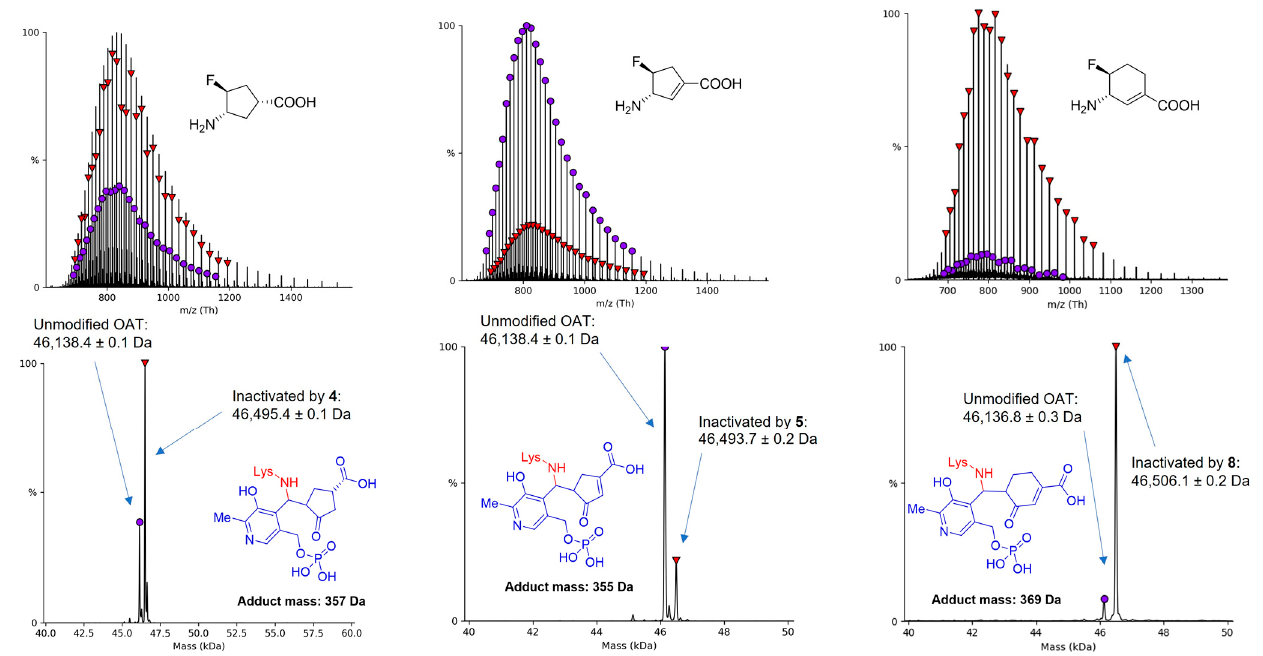
Figure 3. Denaturing intact protein mass spectrometry of h OAT inactivated by 4 , 5 , and